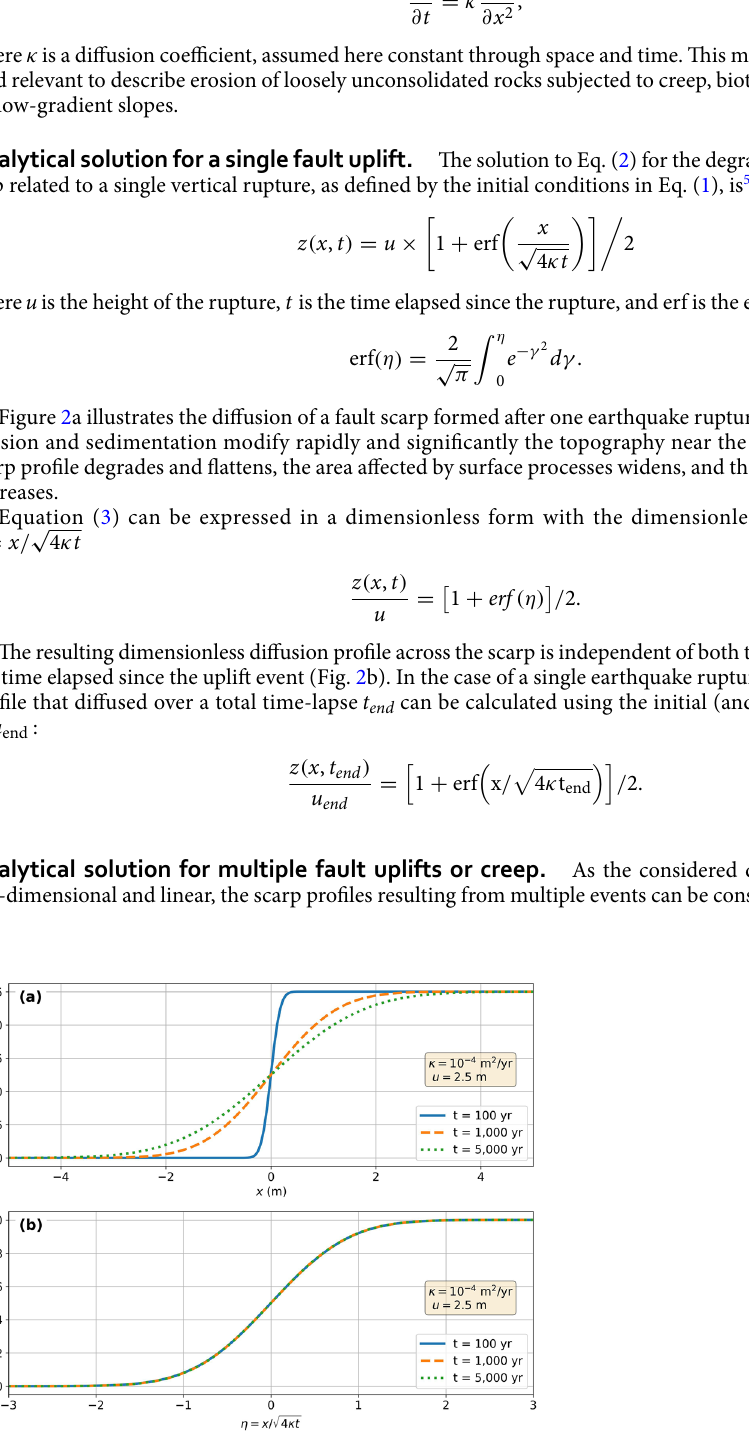
Figure 2. Evolution of a degrading fault scarp. ( a ) Elevation profiles z ( x ) across a fault scarp assuming a single 4 m 2 /yrea. Blue, orange, and green lines show the 2.5 m and a diffusion coefficient κ 10 rupture uplift u − = = degraded scarp profiles after 100, 5000, and 10,000 years, respectively. ( b ) Same profiles using the dimensionless parameters η and z / u . Figure generated using the Python’s matplotlib